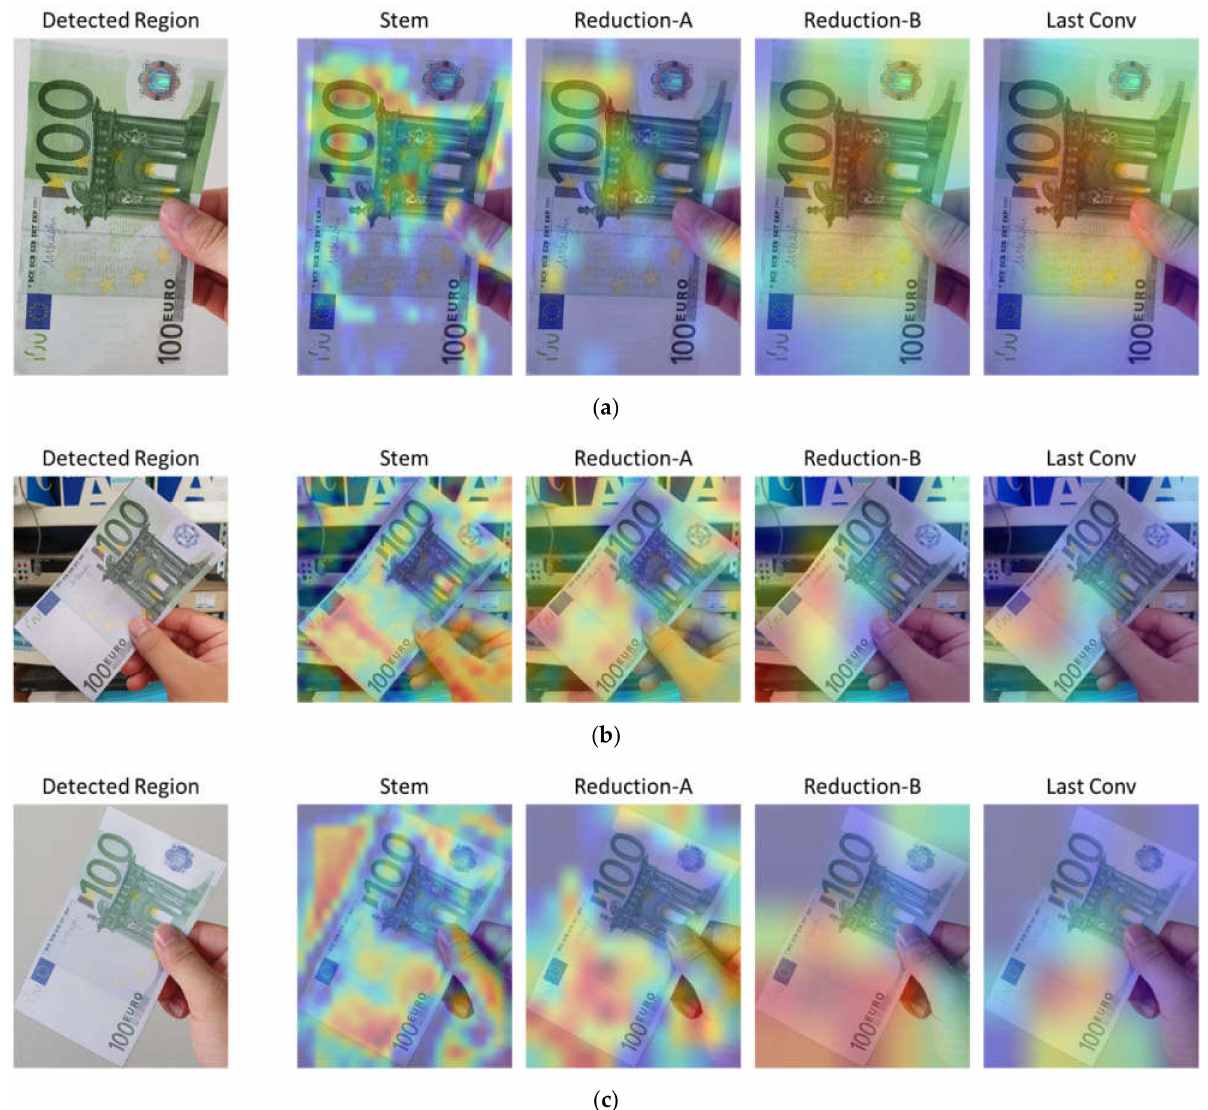
Figure 22. Visualization of CAM at Stem, Reduction-A, Reduction-B, and the last convolutional layers (Figure 4c) of the correctly classified EUR banknotes using Inception-ResNet-v2 trained on the KRW dataset: ( a ) genuine, ( b ) smartphone-reproduced fake, and ( c ) scanner-reproduced